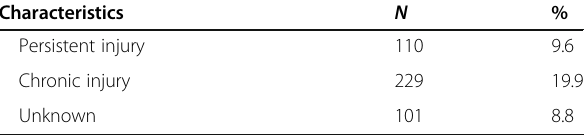
Table 1 Demographic data for the OMMP